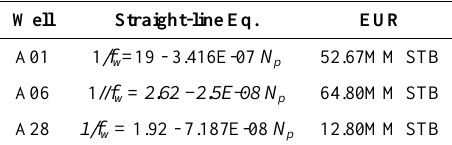
Table 6. EUR from 1/ f w versus N